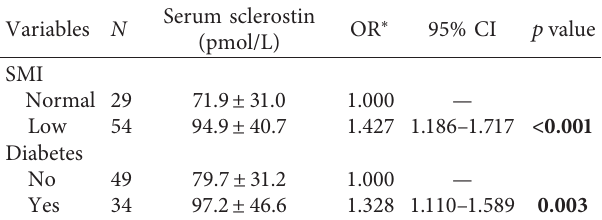
Data are expressed as mean ± SD. OR, odds ratio; CI, confidence interval; SMI, skeletal muscle mass index. ∗ OR adjusted by the effect of other confounders.